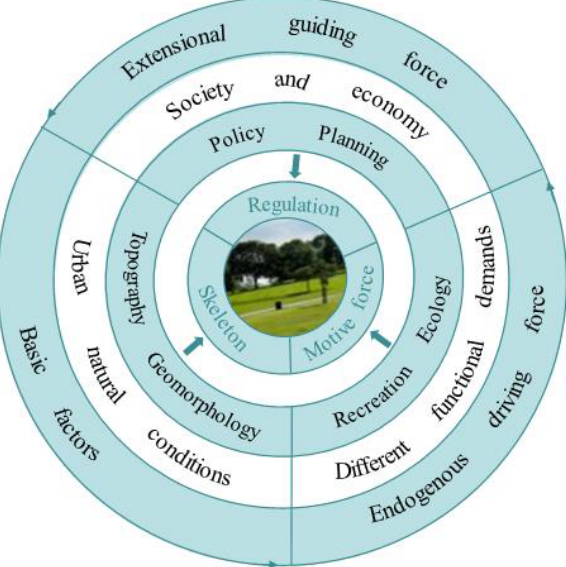
Figure 8. The development mechanism and planning framework of park green space.